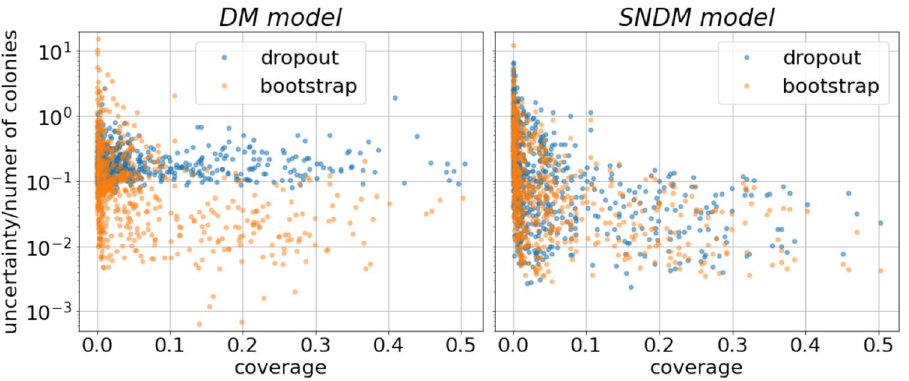
Figure 6. Dependence of the counting uncertainty per single colony on coverage factor calculated for the test subset using both